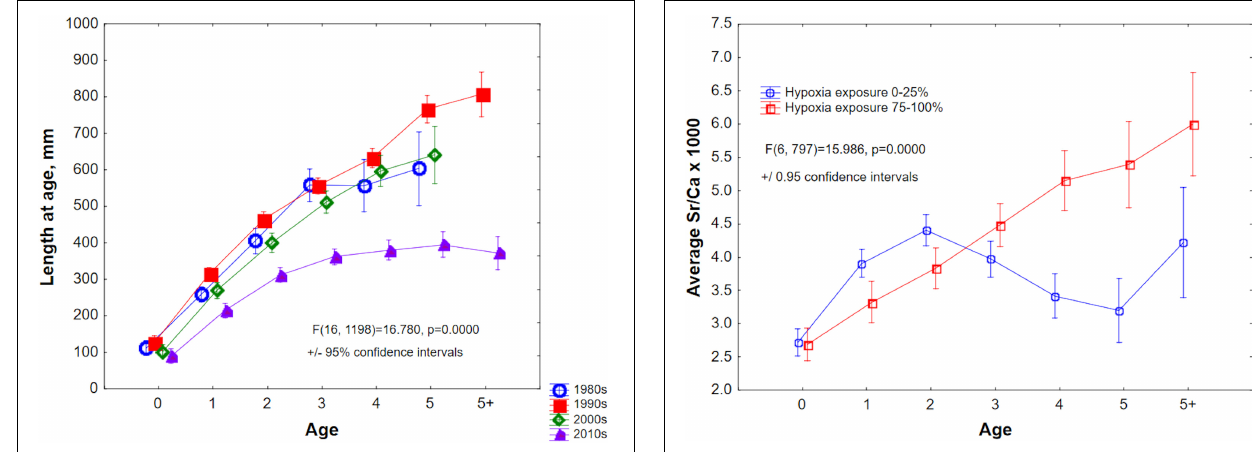
FIGURE 7 | Back-calculated lengths-at-age of Baltic cod, grouped by decade of capture.